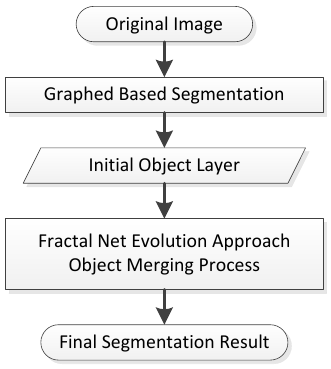
Figure 2. The process of our algorithm